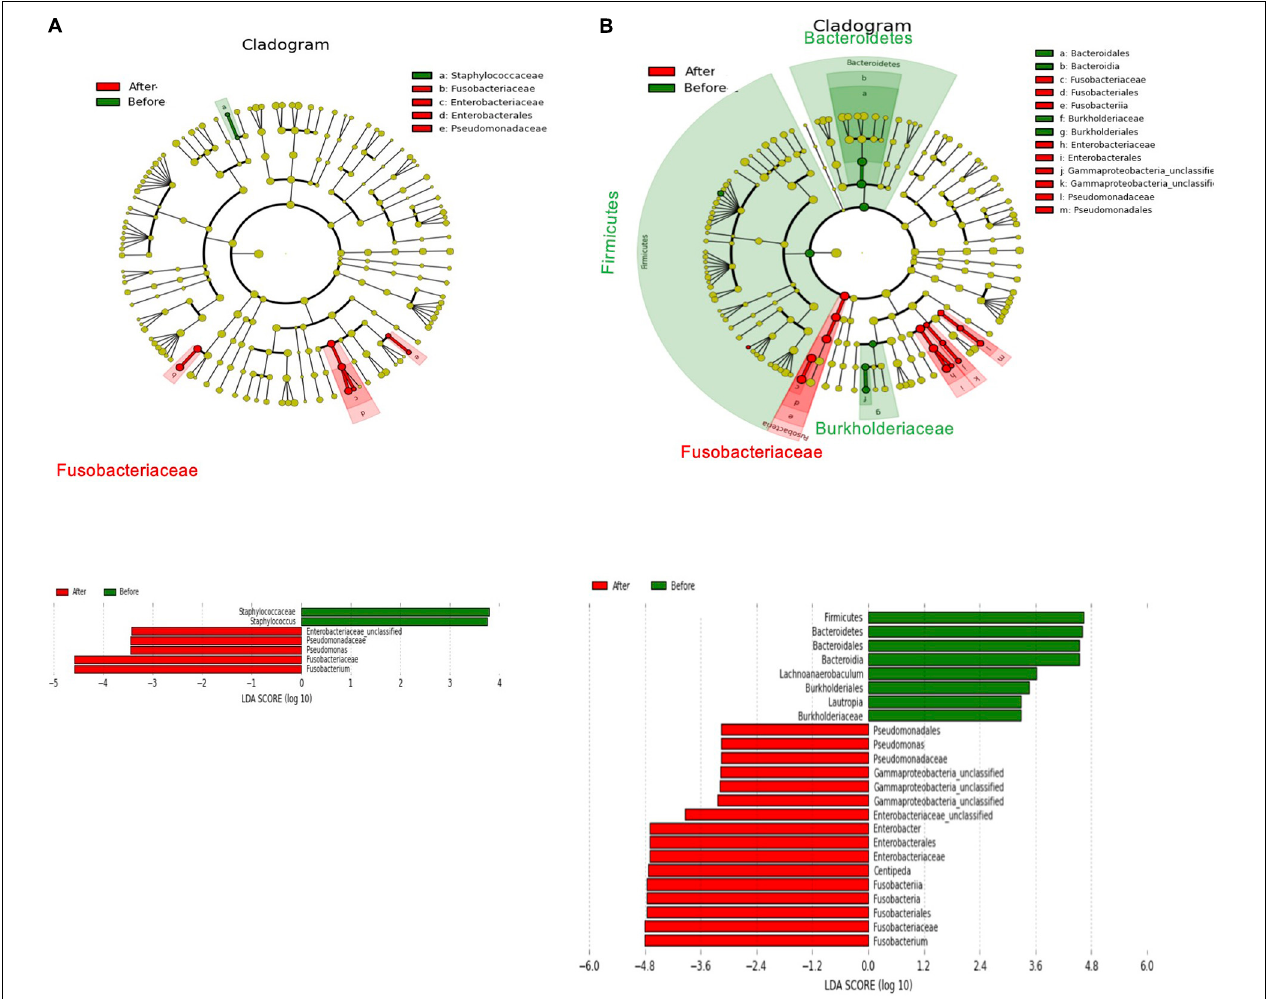
FIGURE 7 | The main abundant taxa that differed before treatment (M0, baseline) and after the 2-week follow-up (M1) in the taxonomic cladogram based on Linear discriminant analysis effect size (LEfSe) analysis and its LDA score from the (A) control group (B) xylitol gum group.